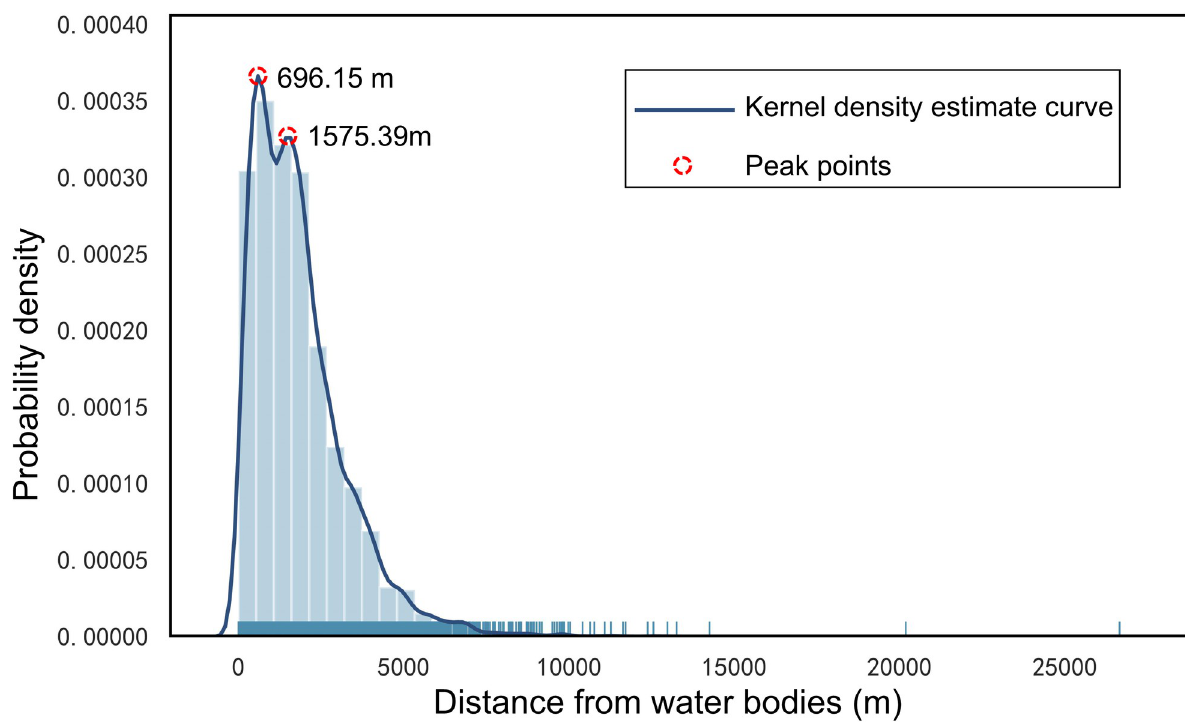
Fig 9. Kernel density estimate curve of the distance of HFRS cases from water